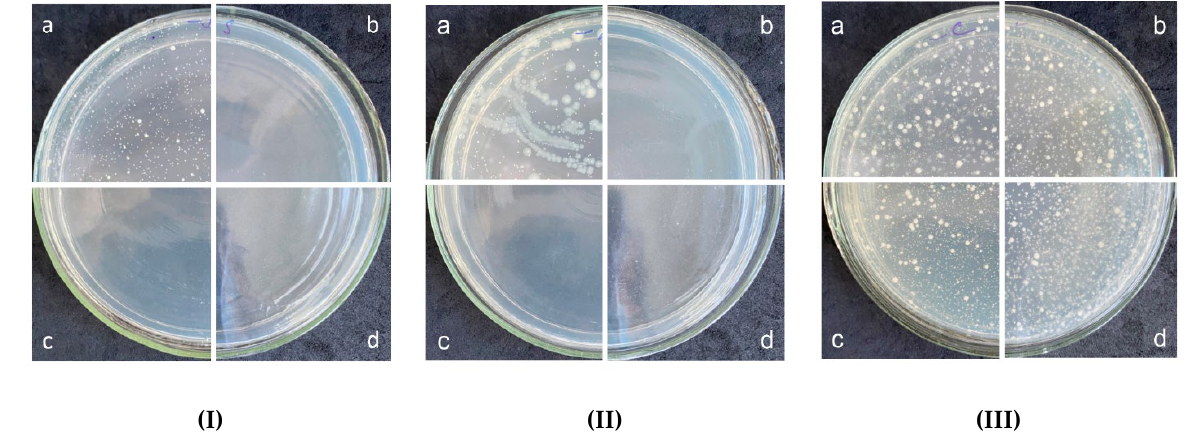
Figure 9. The results of antimicrobial activity of the polymer composite with 5 wt.%-Triclosan against the strain of S. aureus 6538-P ( I ), Kl. pneumoniae 10031 ( II ), C. albicans 10231 ( III ) after three cycles of attrition: a—negative control; b—1st cycle; c—2nd cycle; d—3rd cycle.